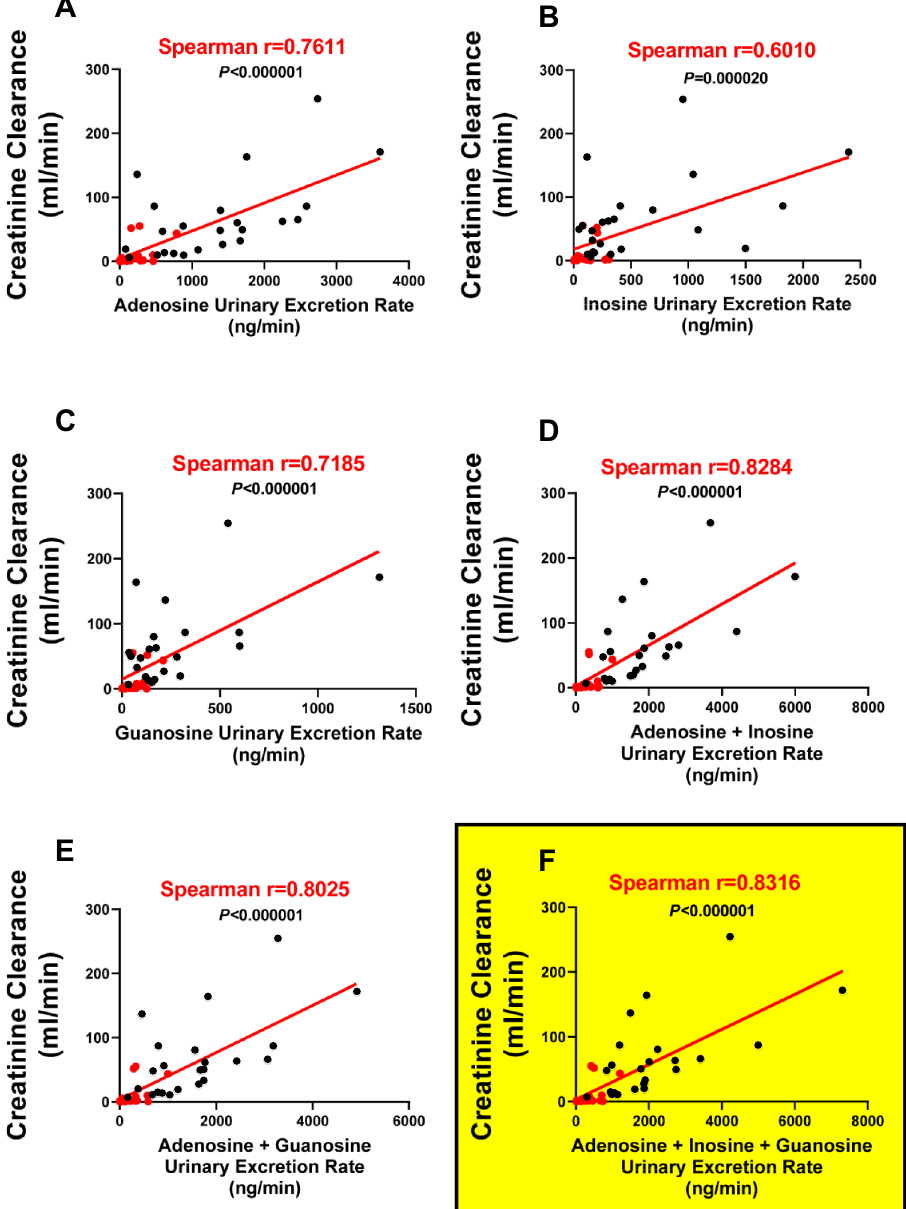
Figure 3. Correlations between urinary excretion rates (ng/min) of adenosine ( A ), inosine ( B ), guanosine ( C ), adenosine + inosine ( D ), adenosine + guanosine ( E ) and adenosine + inosine + guanosine ( F ) versus creatinine clearance. The summation of the excretion rates of adenosine + inosine + guanosine ( F ) yielded the strongest positive correlation with renal function. Red symbols represent data from patients with acute kidney